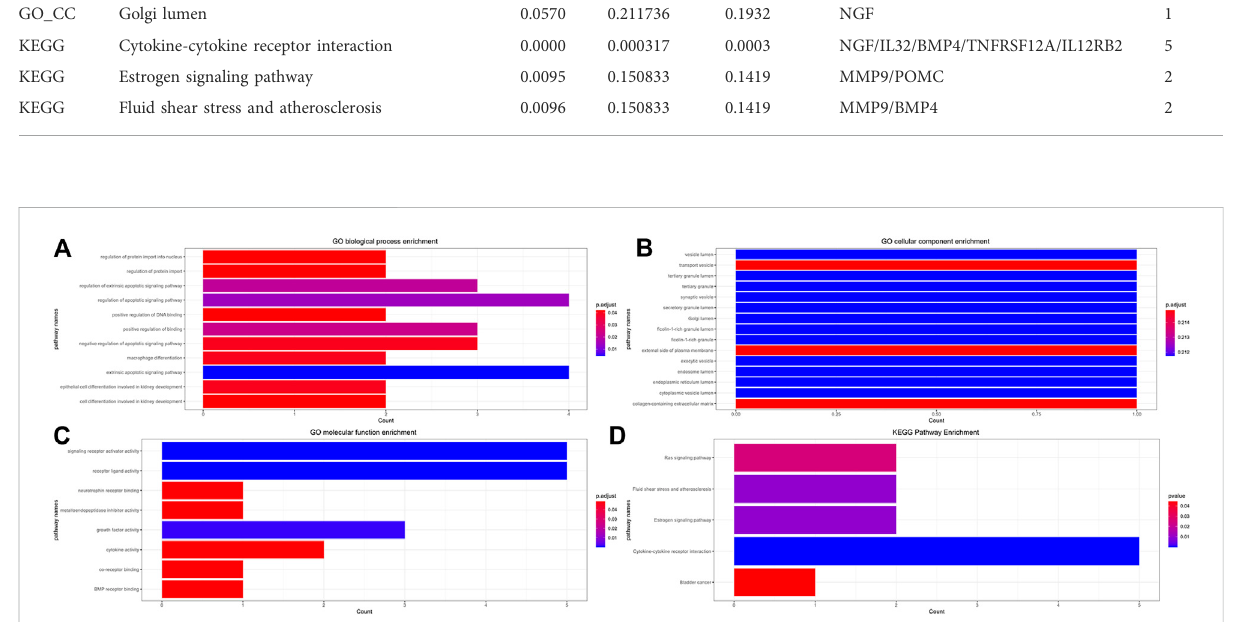
FIGURE 12 Functional GO and KEGG Enrichment Analysis of Immune Genes. (A) GO biological process enrichment, (B) GO cellular component enrichment, (C) GO molecular function enrichment, (D) KEGG pathway